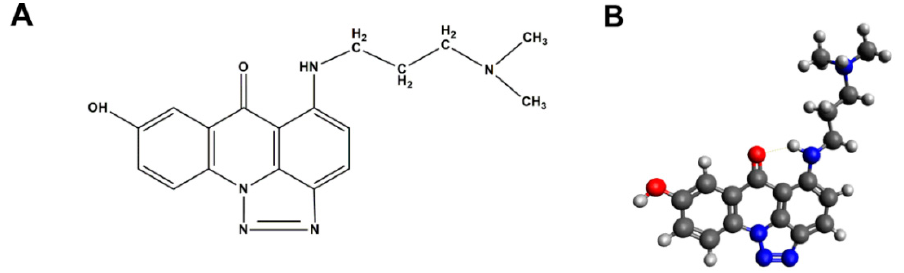
Figure 1. Triazoloacridinone derivative, C-1305. ( A ) Chemical formula of 5-((3-(dimethylamino)propyl)amino)-8-hydroxy-6H-[1,2,3]triazolo[4,5,1-de]acridin-6-one (C 18 H 19 N 5 O 2 )—C-1305; ( B ) Predicted 3-dimensional (3D) structure of C-1305. The 3D structure was generated as described under materials and methods section (red-oxygen, blue-nitrogen, black-carbon, grey- hydrogen).